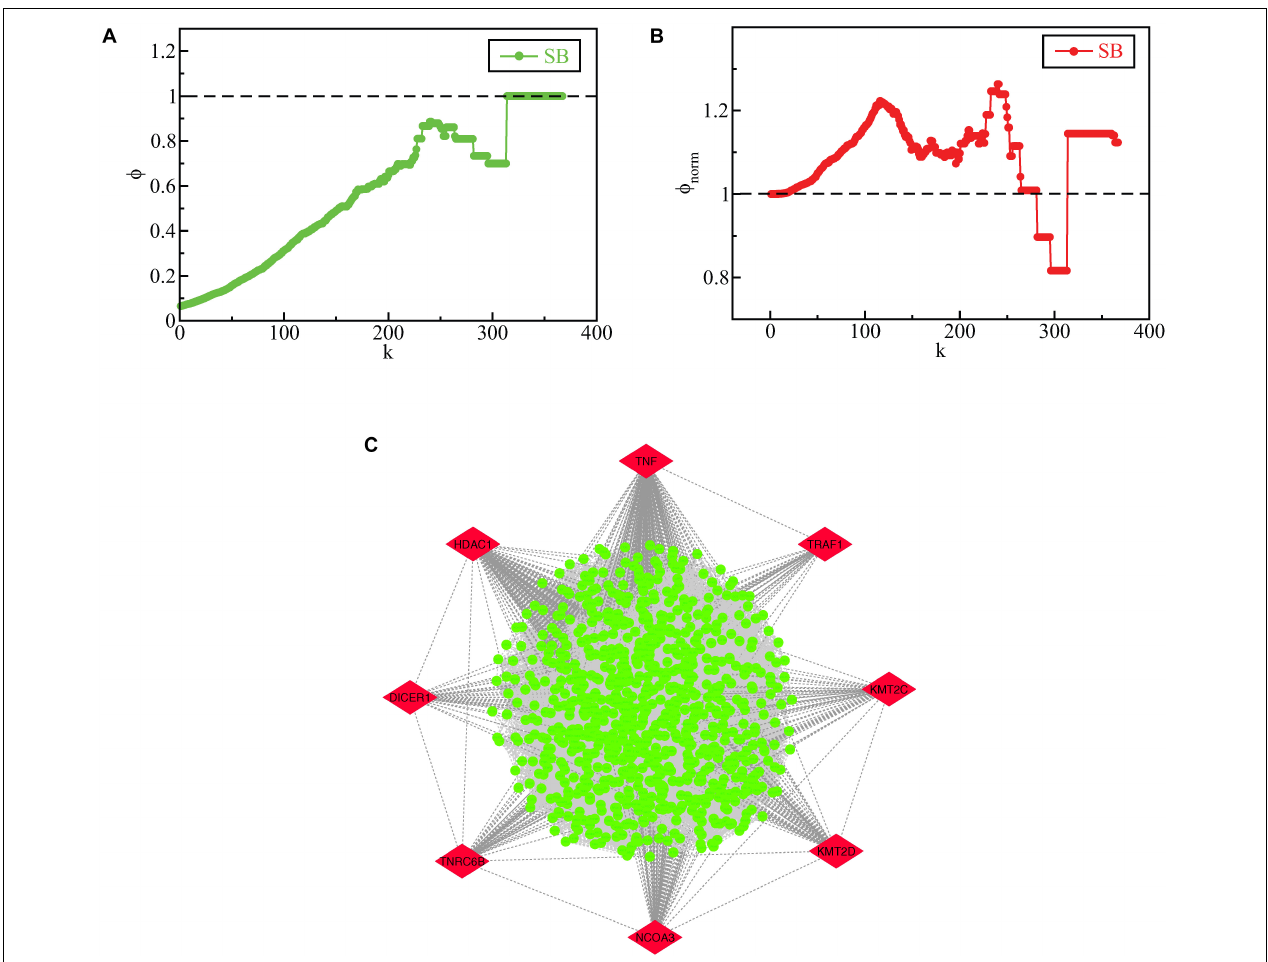
FIGURE 8 | (A) raw rich-club coefficient ( φ ) of the SB network as a function of degree k . (B) normalized rich-club coefficient ( φ norm ) of the SB network as a function of degree k . (C) rich club nodes of the SB network, the KR genes which emerged as rich-club nodes are highlighted in